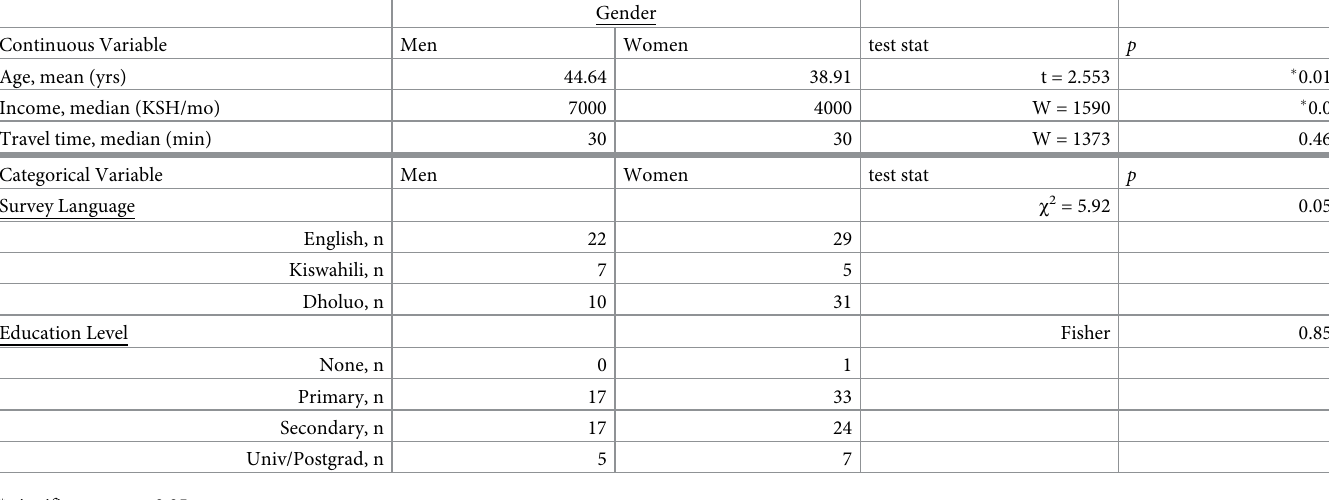
Table 4. Comparison of continuous and categorical variables by gender amongst HIV-infected patients (n = 104).